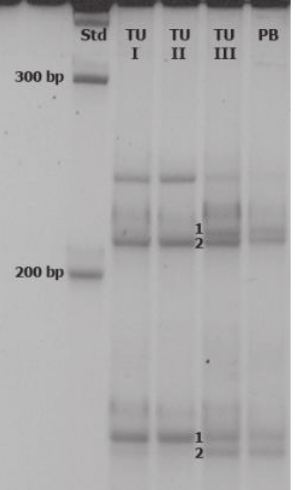
Figure 8: Analysis of electrophoretic band patterns: X chromosome inactivation pattern according to a methylation-sensitive PCR of the FMR1 gene region. A 100% skewing of the tibia tumour (TU I) as well as the fibula tumour (TU II) could be detected (presence of a single cell line consisting of the methylated (M) allele 2 and the unmethylated (UM) allele 1). The analysis of the distal lesion of the tibia (TU III) as well as the peripheral blood (PB) showed a random X inactivation (four distinct bands of equal intensity that represent the two methylated and unmethylated